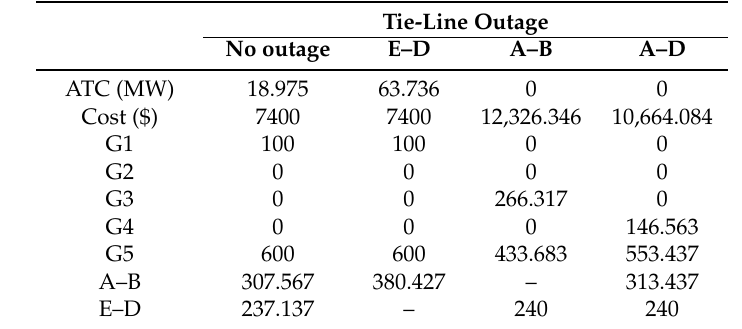
ATC and ED results of PJM 5-bus system under different tie-line outages with 700 MW demand.